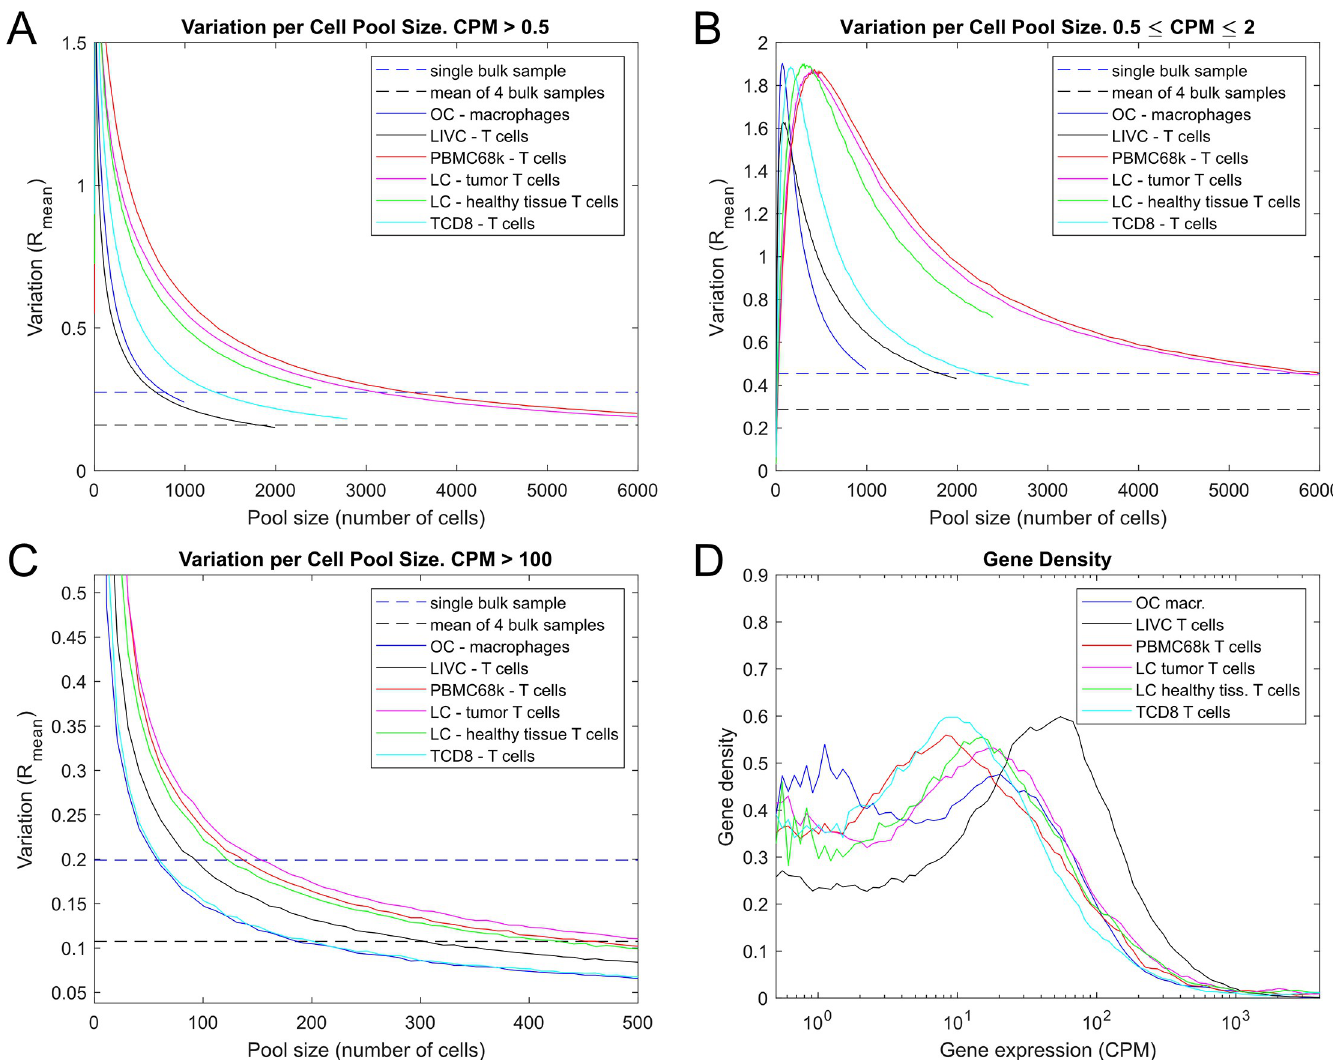
Fig 4. Cell pool size needed for stable average gene expression. A-C. DSAVE total cell pool variation estimation of 6 cell populations for different gene expression ranges, compared with the average variation of a bulk sample and the average variation of the mean of 4 bulk samples. D. Gene expression density in log 10 scale for 6 cell populations from different datasets in the range of 0.5–4000 CPM. The graph shows that the highly expressed genes are few in comparison to the lowly expressed genes, and that this distribution varies between cell populations.